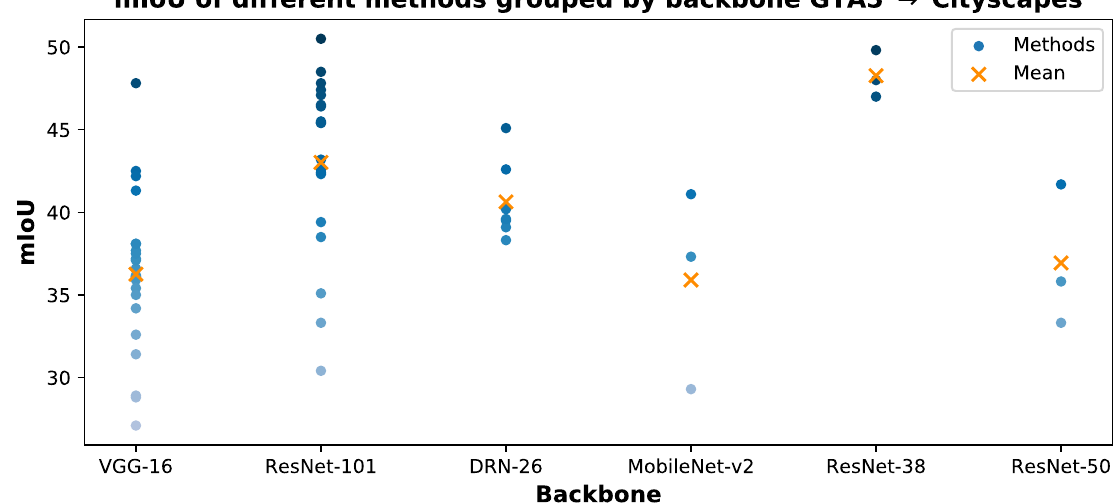
Figure 7. Mean IoU (mIoU) of different methods grouped by backbone in the scenario adapting source knowledge from GTA5 to Cityscapes (see Table 1). Backbones are sorted by decreasing the number of entries. Orange crosses represent the per-backbone mean mIoU. Only the backbones with 3 or more entries are